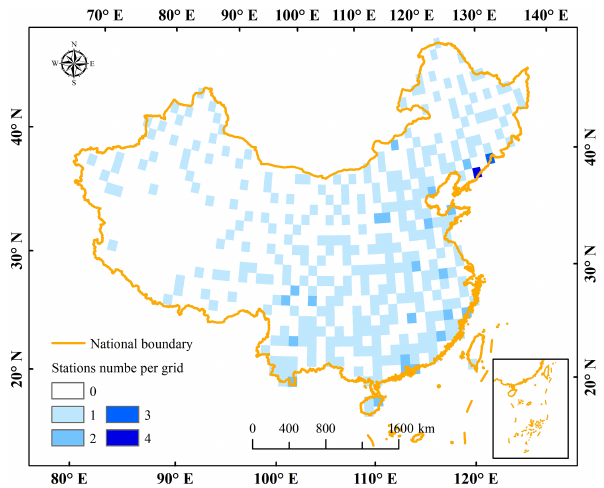
Figure A1. The number and location of stations used in GPCC over China.